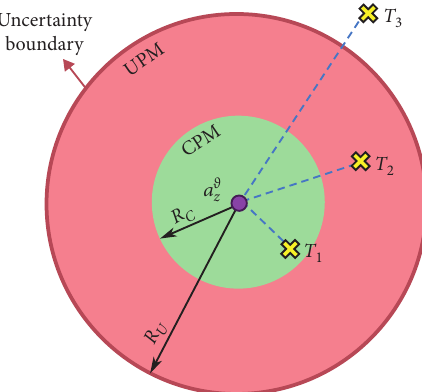
Figure 1: CPM and UPM. T UPM, respectively. T